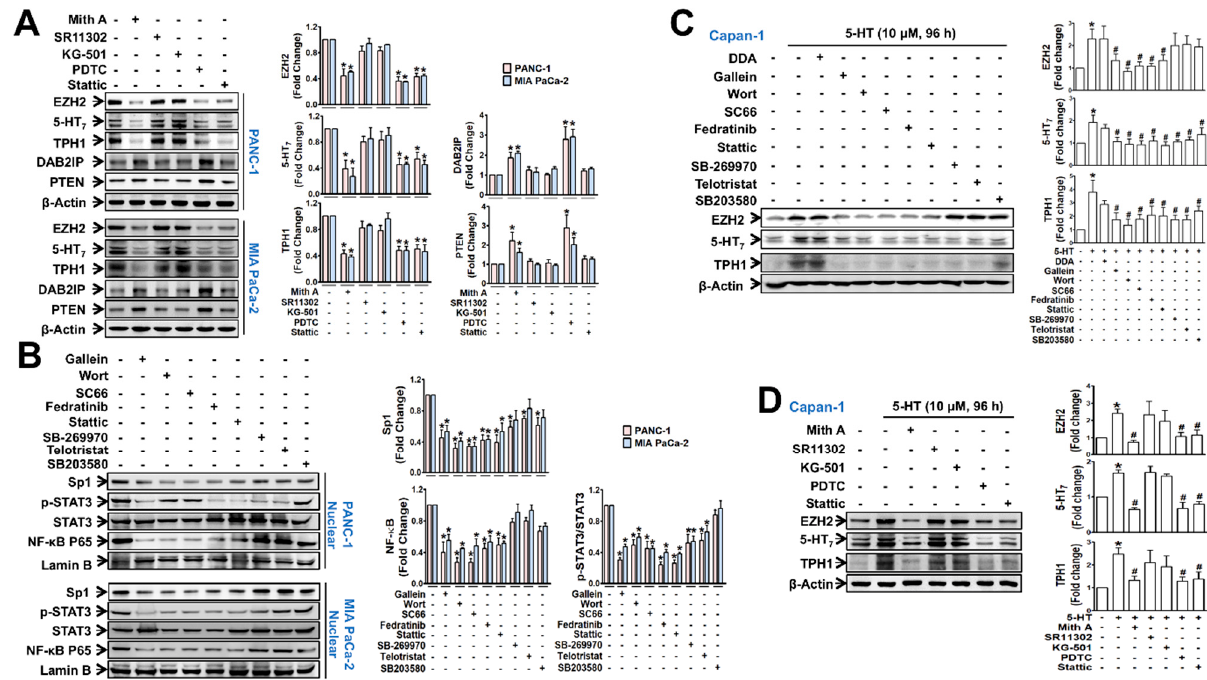
Figure 5. Transcription factors, NF- κ B, SP-1, and p-STAT3, are associated with PI3K/Akt and JAK2/STAT3 signaling, leading to 5-HT 7 , TPH1 and EZH2 expression. ( A ) Immunoblots of 5-HT 7 , TPH1 and EZH2 in PANC-1 and MIA PaCa-2 cells treated with mithramycin A (Mith A, 0.1 µ M), SR11302 (10 µ M), KG-501 (10 µ M), PDTC (10 µ M), or stattic (10 µ M) for 24 h. ( B ) Nuclear levels of SP-1, p-STAT3, and NF- κ B (p65) in PANC-1 and MIA PaCa-2 cells treated with gallein (10 µ M), wortmannin (3 µ M), SC66 (3 µ M), fedratinib (3 µ M), stattic (3 µ M), SB-269970 (3 µ M), telotristat (3 µ M), or SB203580 (10 µ M) for 48 h. Immunoblots are the representative of three independent experiments, and results are the mean ± SEM in the bar diagram. * p < 0.05 compared to the vehicle-treated control group. ( C , D ) Immunoblots of 5-HT 7 , TPH1 and EZH2 expression in Capan-1 cells. Cells were pretreated with 5-HT (10 μ M) for 96 h prior to the treatment with signaling molecule inhibitors for 48 h ( C ) and with transcription factor inhibitors for 24 h ( D ). The bar graphs represent the means ± SEM from three independent experiments. * p < 0.05 compared to the vehicle-treated control. # p < 0.05 compared to the 5-HT-treated group. The uncropped Western Blot images can be found in Figure S6.